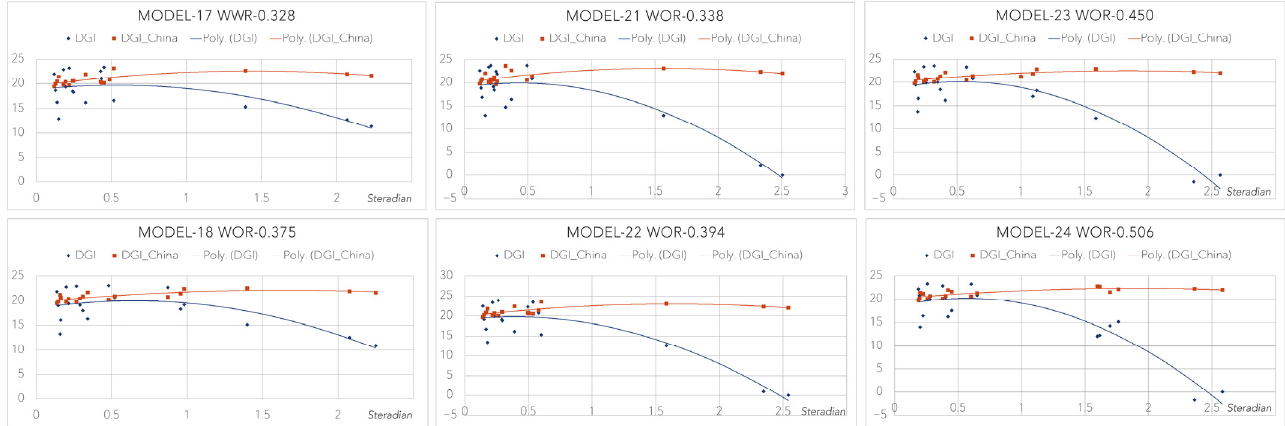
Figure 11. Comparative study on window sizes (WWR ≤ 0.3) with solid angles ( X -axis) against DGI and DGI China evaluation ( Y -axis).